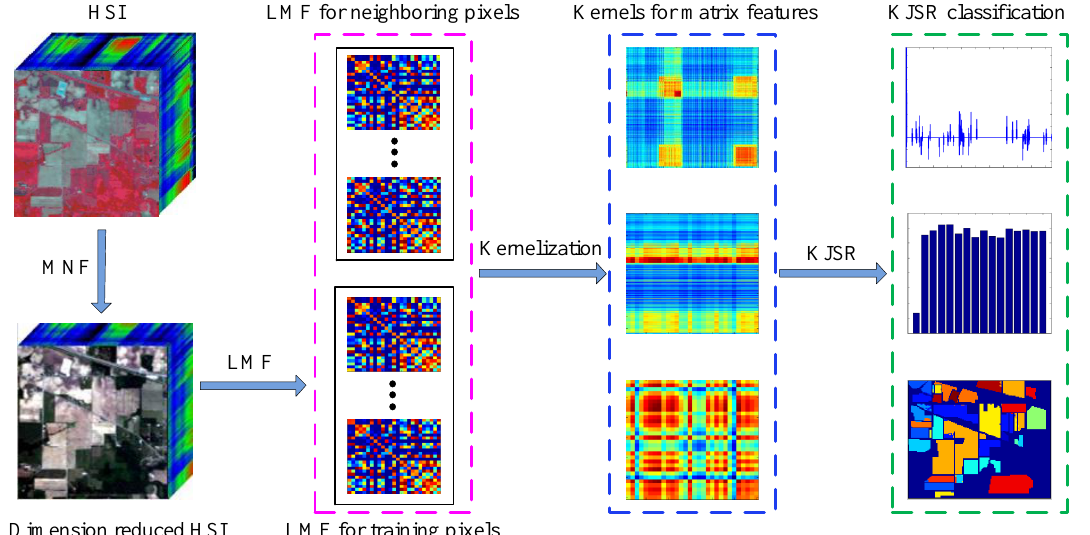
Figure 1. The framework of the proposed LMFKJSR algorithm, which mainly consists of three steps, i.e., maximum noise fraction-based dimensionality reduction, local matrix feature extraction, and matrix kernel-based JSR